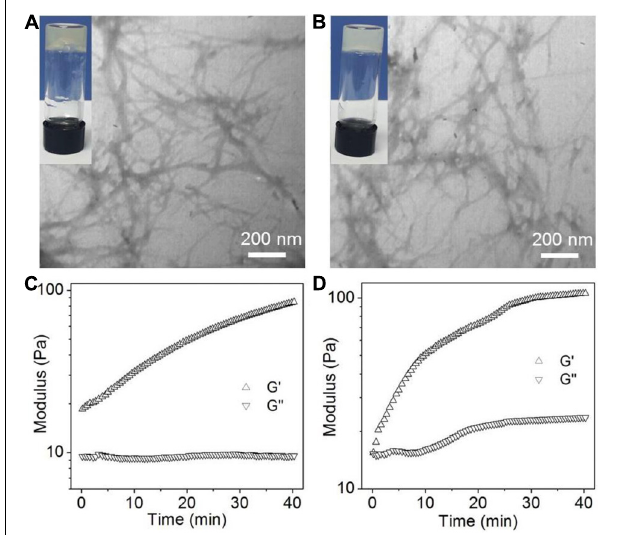
FIGURE 2 | (A,B) Photo and TEM images of the supramolecular hydrogels self-assembled from peptide 1 (A) and 2 (B) . (C,D) Oscillatory rheology behaviors of the supramolecular hydrogels self-assembled from peptide 1 (C) and 2 (D)